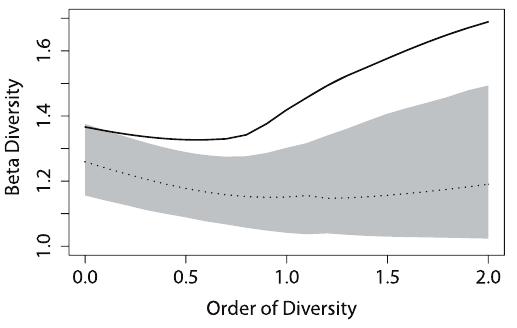
Figure 5. Paracou and BCI b diversity. b diversity profile between Paracou plots (solid line) is compared to that of any two plots of BCI (dotted line with 95% confidence envelope).